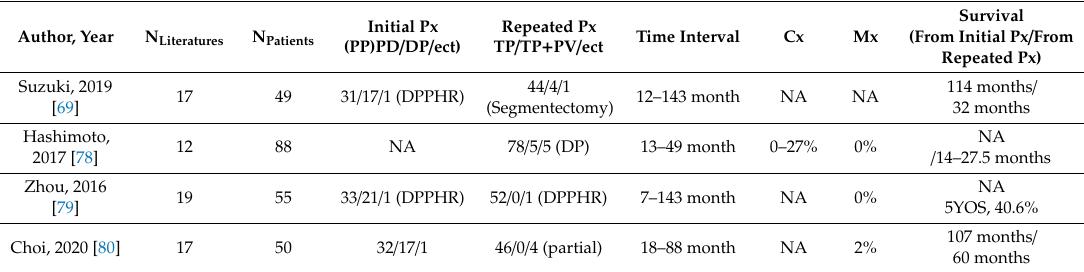
Table 5. Summary of review articles of repeated pancreatectomy for recurred pancreatic cancer in remnant